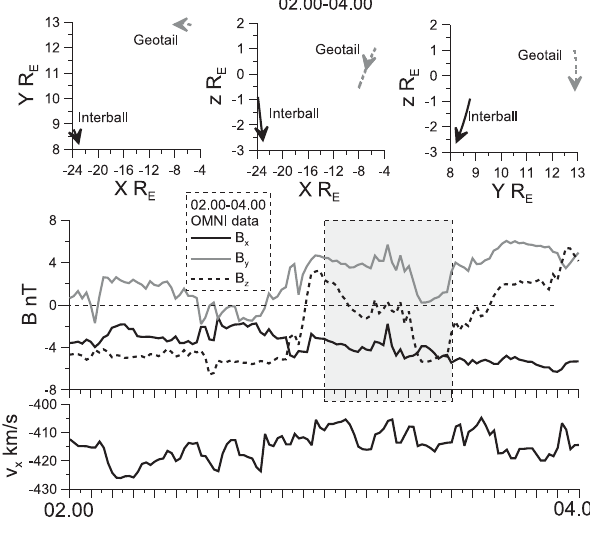
Fig. 10. Positions of Interball and Geotail spacecraft on 15 Decem- ber 1996 from 02:00 to 04:00. OMNI data: magnetic field and solar wind